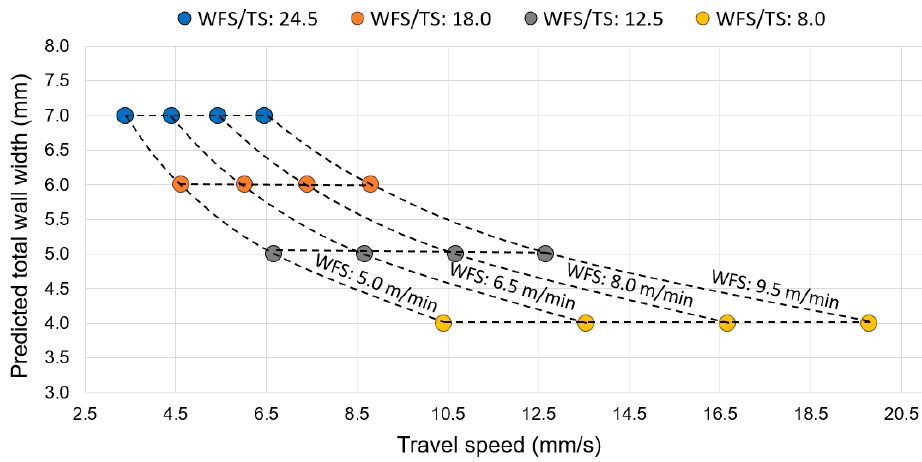
Figure 5. Predicted work envelop. Table 3. Matrix of experiments to build the work